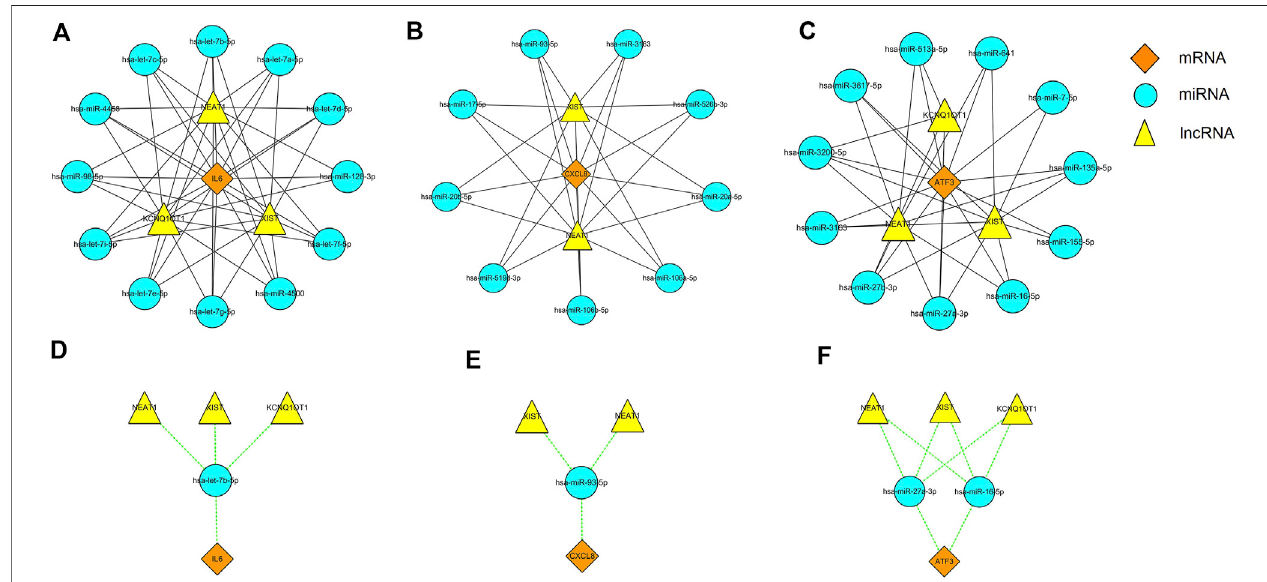
FIGURE9| ThreeceRNAnetworksofIL6,CXCL8andATF3andthepotentialRNAregulatorypathways. (A) ceRNAnetworkofIL6. (B) ceRNAnetworkofCXCL8. (C) ceRNA network of ATF3. (D) NEAT1/XIST/KCNQ1T1-let-7b-5p-IL6. (E) NEAT1/XIST-miR-93-5p-CXCL8. (F) NEAT1/XIST/KCNQ1T1-miR-27a-3p/miR-16-5p- ATF3. Diamonds represent the hub genes, circles represent miRNAs and triangle represents lncRNAs.